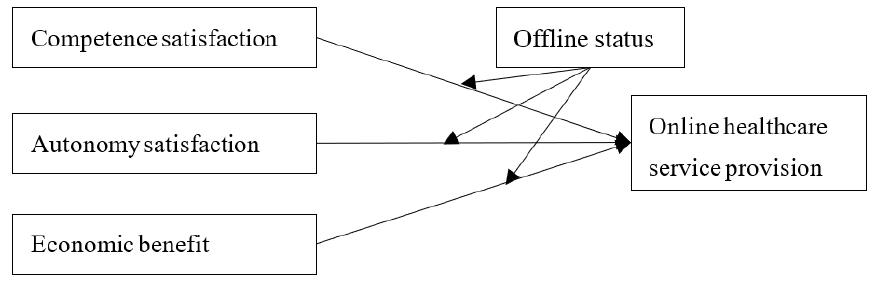
Figure 1. Research